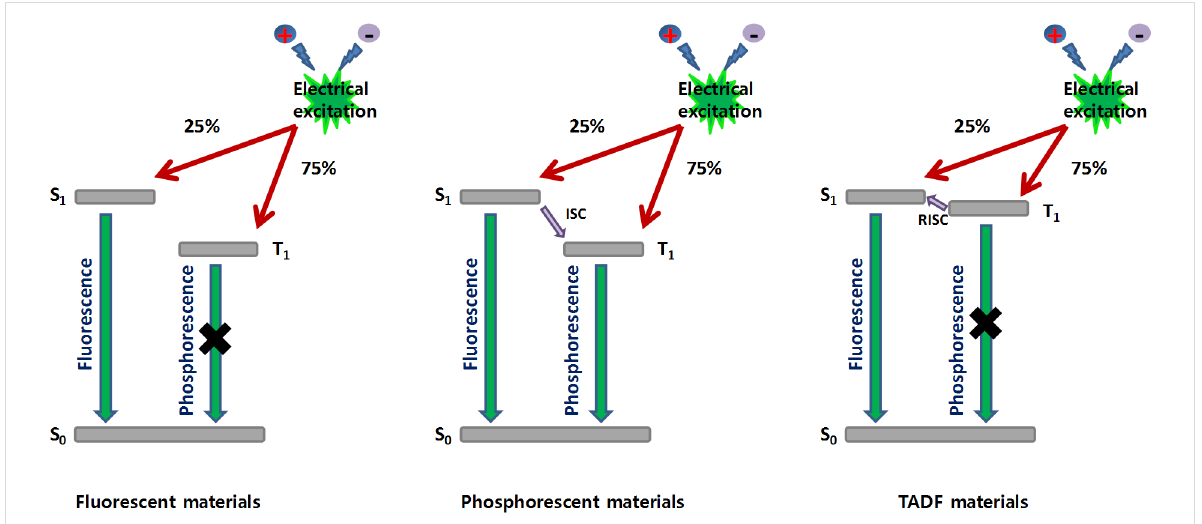
Figure 1: Radiative deactivation pathways existing in fluorescent, phosphorescent and TADF